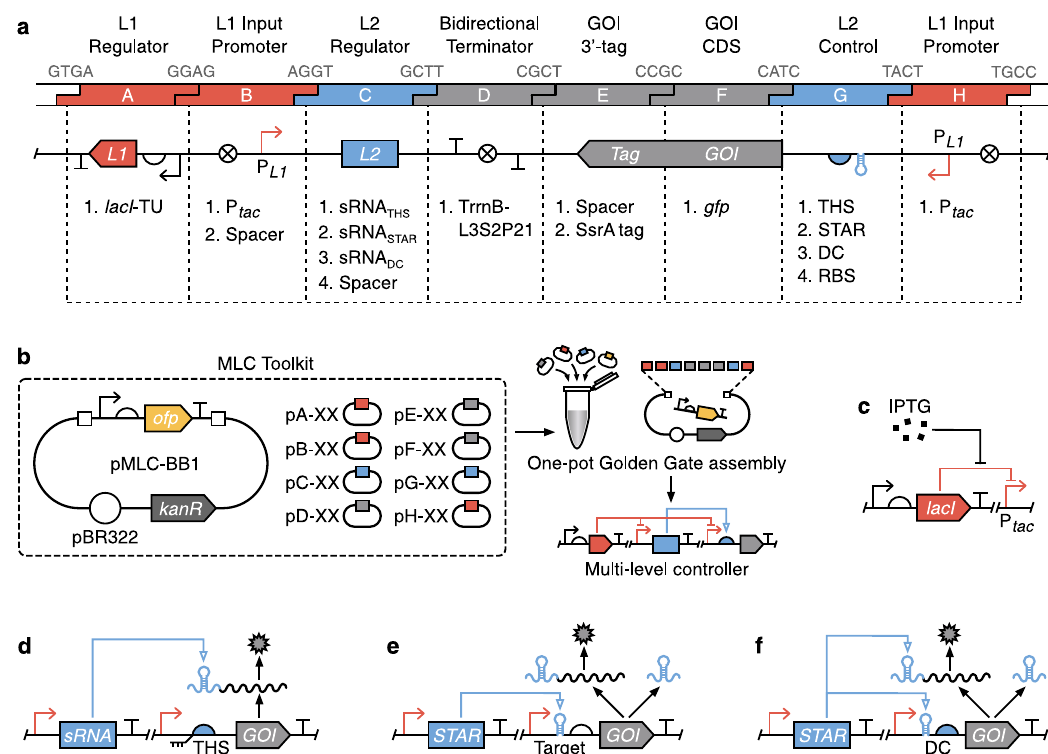
Fig. 2 Combinatorial assembly of gene expression controllers. a Summary of the 8-part genetic template used to allow for systematic exploration of direct and multi-level gene regulation. The 4-bp overhangs used for Golden Gate assembly are shown in grey at their respective junctions. Available genetic elements are listed below each corresponding part type (A – H). b The MLC toolkit contains a set of plasmids that can be combined using Golden Gate assembly to create a variety of direct and multi-level controllers (Supplementary Fig. 3). c The lacI transcription factor responsive to IPTG used for level 1 ( L1 ) transcriptional regulatory control. d Toehold switch (THS) translational regulator used for level 2 ( L2 ) control. e Small transcription activating RNA (STAR) transcriptional regulator used for L2 control. f Dual control (DC) transcriptional and translational regulator used for L2